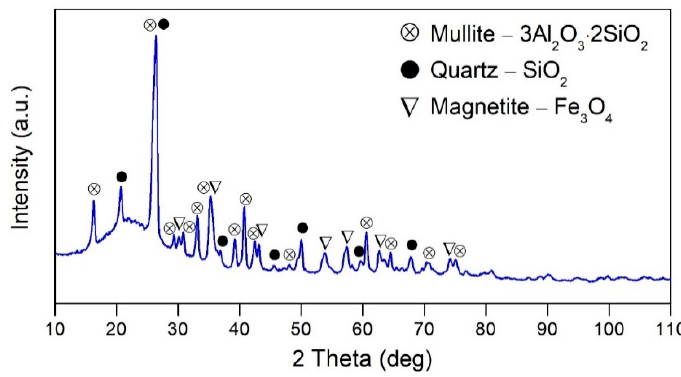
Figure 1. X ‐ ray diffraction (XRD) patterns of raw CFA from the Omsk TPS ‐ 4. Figure 1. X-ray di ff raction (XRD) patterns of raw CFA from the Omsk